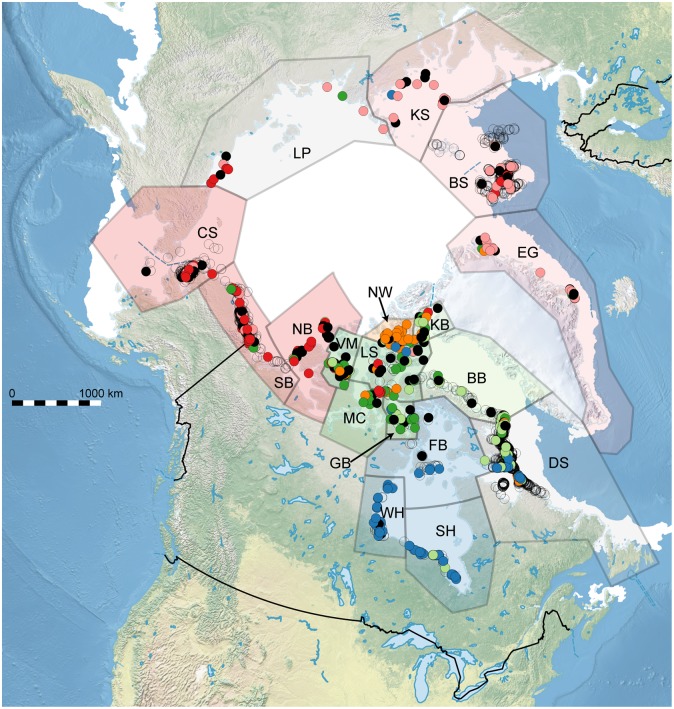
Sampling locations for 476 of the 495 polar bears used in this analysis; the remainder did not have lat–long coordinates.Individuals are colour-coded by genetic cluster similarly to the colour scheme for K = 6 in Fig 2. Black samples are unassigned (i.e., Qmax < 0.5). Uncoloured individuals are those that were used in the original study but were not included in our random subset of 30 individuals per management unit; their predicted cluster memberships based on BAPS trained clustering are shown in Fig C of S1 File. Management unit abbreviations are as in Table 1. Approximate sea ice extent during the breeding season is shown using measurements for April 15, 2008 [78], though there is great spatial heterogeneity in sea ice thickness and concentration, as well as great intra-seasonal and inter-annual variability. Note that this map (and the data) does not reflect a 2014 boundary change between NB and SB made by the territorial governments and the co-management boards with management authority for these two subpopulations, because it has not yet been evaluated by the IUCN Polar Bear Specialist Group.